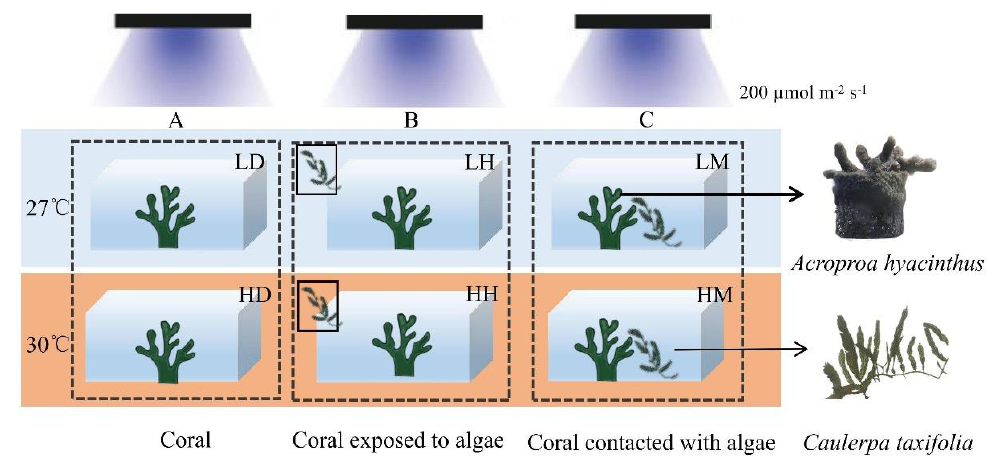
Figure 1. Experimental design. ( A ) Control group, ( B ) indirect contact group, ( C ) direct contact group. The orange and blue colors represent the different temperature treatments (27 ◦ C and 30 ◦ C). The conditions for the treatments are presented in Table S1. Three aquariums were set for each treatment, n =